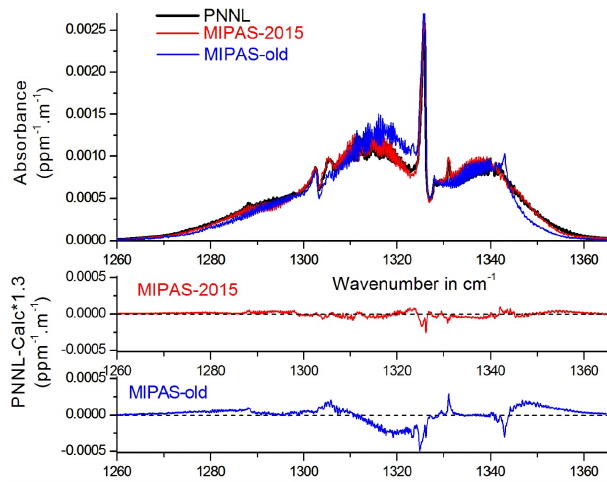
Figure 7. Upper panel: absorption cross sections from PNNL (Sharpe et al., 2004, black trace), and calculated using MIPAS- OLD (blue trace) and MIPAS-2015 (red trace); lower panel: corre- sponding residuals. For these calculations, the contributions of hot bands and bands from isotopologues other than H 14 N 16 O 3 were ac- counted for by multiplying the calculated absorption cross sections by the ratio Z Vib ( 300K )/I a = 1 . 314 (see Eq. 1).